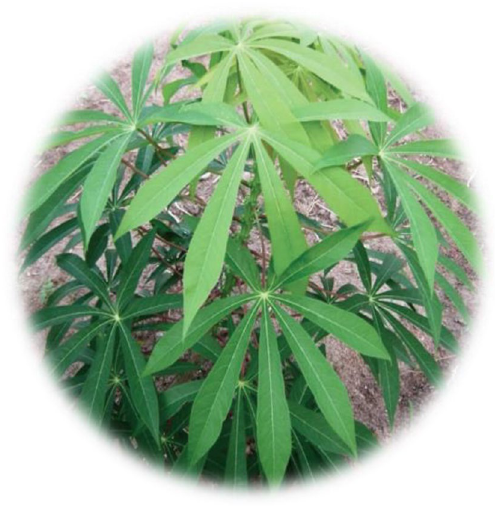
Fig. 11 Manihot esculenta as a